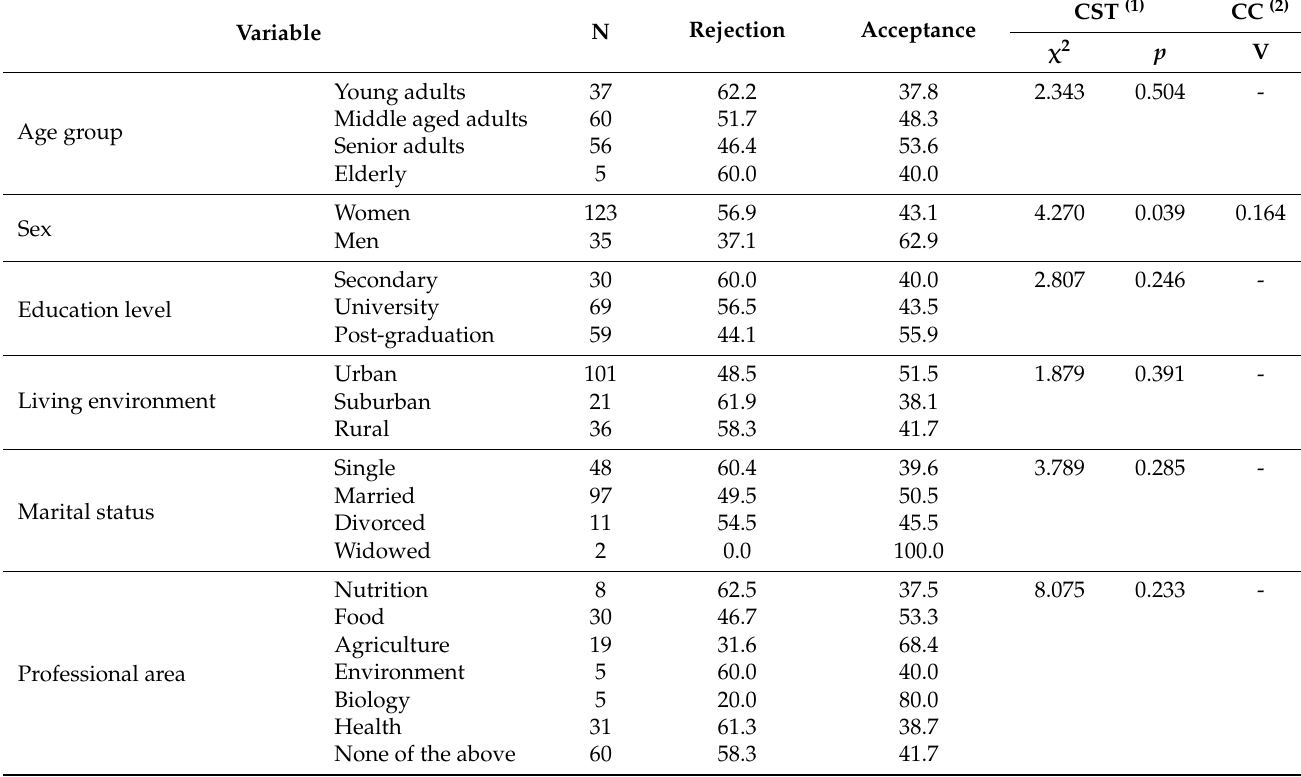
women, whereas, for the variable professional area, people who have jobs related with biology and agriculture demonstrated better acceptance. Table 7. Associations between the acceptability of food products containing EI and the sociodemographic variables studied. Variable